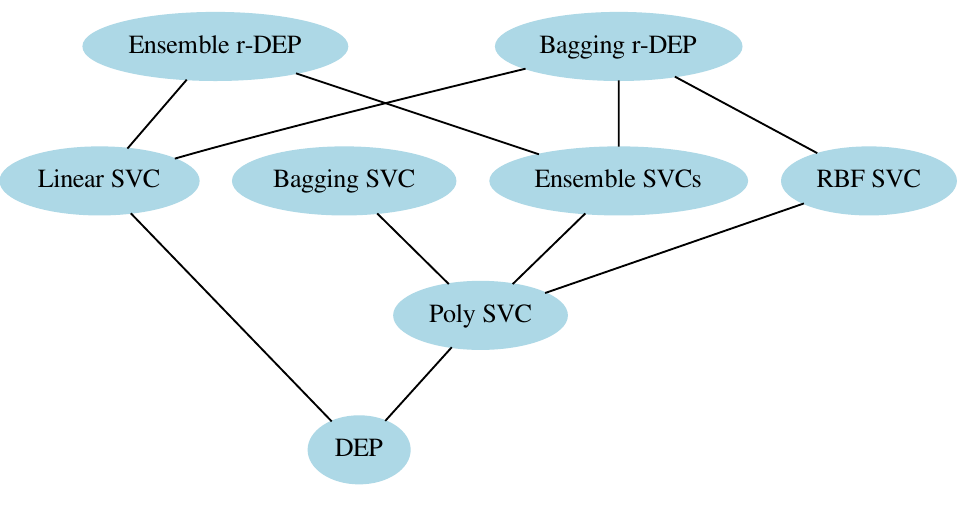
Figure 5. Hasse diagram of paired Student’s t-test with confidence level at